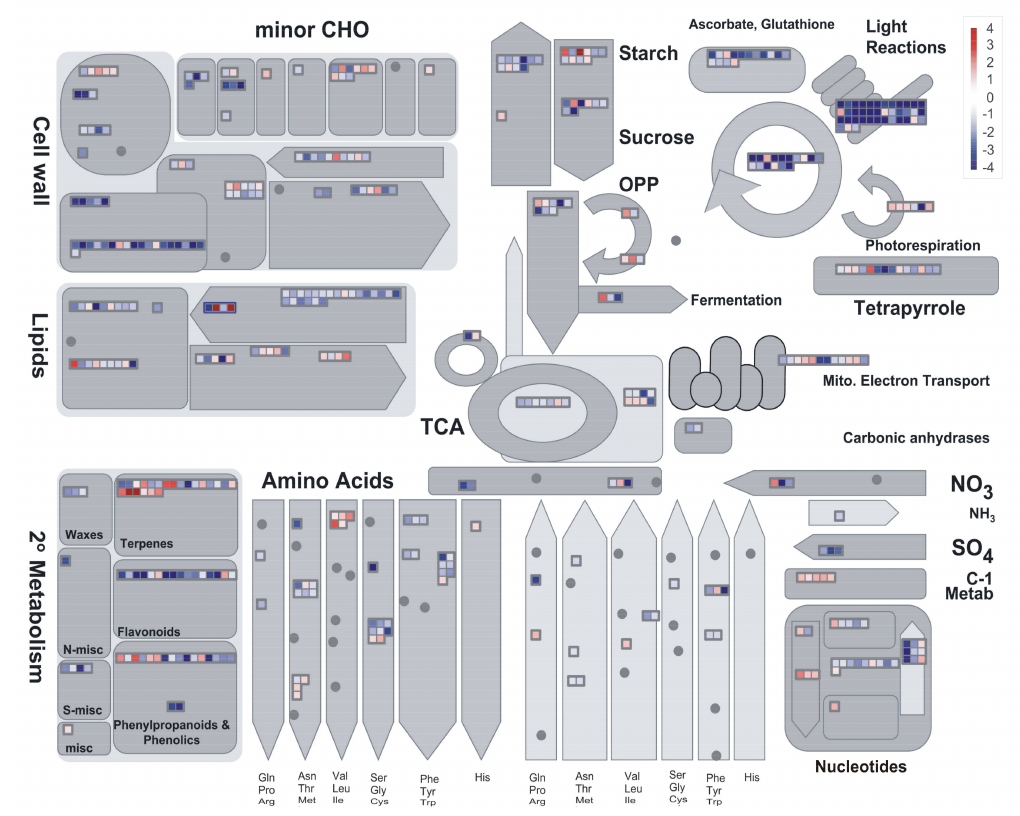
Figure 2. Comparison between gene expression in D seeds incubated in water for either 8 h or 8 d at 30 ◦ C. MapMan Metabolism overview: single DEGs are represented by elementary squares grouped in functional BINs and their color indicates the relative expression level in this contrast (in terms of log 2 FC, color scale on the right upper corner), with red showing relative higher expression after 8 d and blue after 8